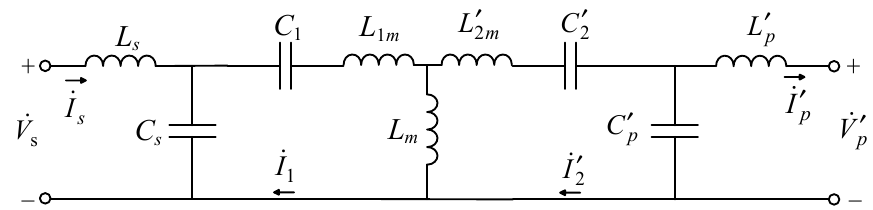
Figure 6. The re-coupling logic of the A phase drive signal.